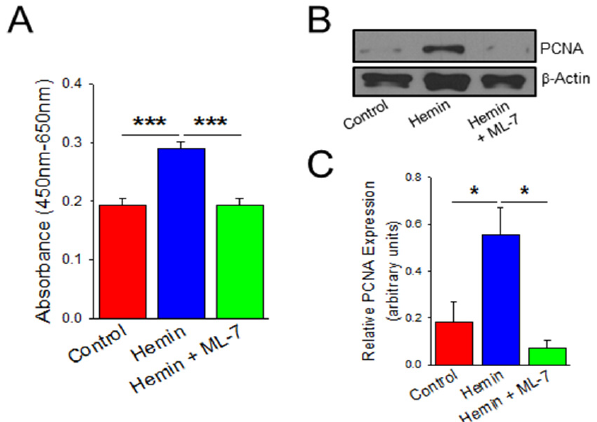
Figure 2. Hemin upregulates EndoMT transcription factors in human pulmonary artery endothelial cells. ( A ) Representative western blot images denoting SNAI1 and SLUG expression over time in hemin (5 µ M)-treated HPAECs compared to PBS vehicle (control). Time course is constant from Figure 1 with β -actin duplicated. Bar graph summarizing relative SNAI1 ( B ) and SLUG ( C ) protein expression for hemin (5 µ M)-treated HPAECs compared to PBS control at 8 h ( n = 3). ** indicates p < 0.01; SNAI1, Snail homolog 1; SLUG (SNAI2), Snail homolog 2.